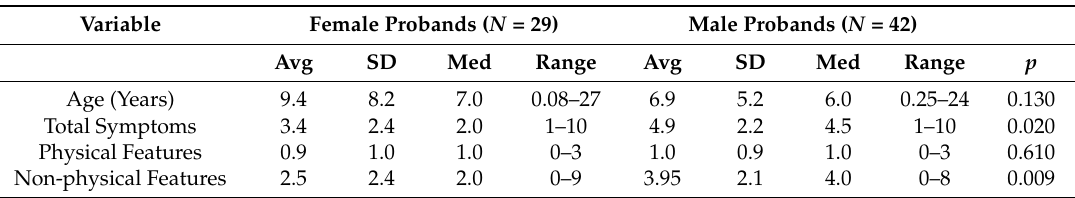
Table 1. Descriptive statistics of clinical features by gender in those with the 15q11.2 BP1-BP2 microdeletion. Variable Female Probands ( N =